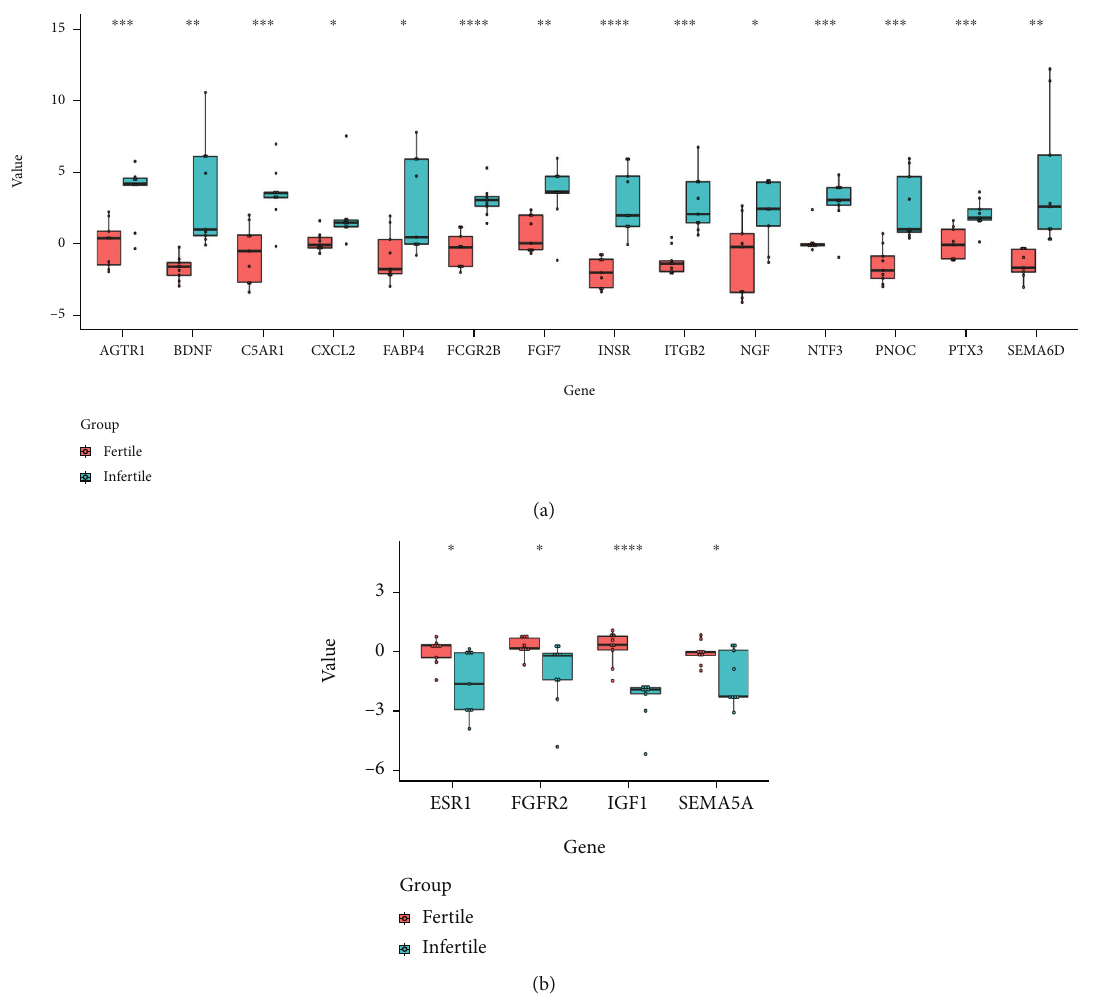
Figure 9: Expression of DEIRGs in the endometria of the infertile and fertile females with endometriosis. (a) Upregulated DEIRGs were highly expressed in the infertile group. (b) Downregulated DEIRGs were decreased in the infertile group (Unpaired Student ’ s t test was used to compare two groups. ∗ P < 0 : 05 ; ∗∗ P < 0 : 01 ; ∗∗∗ P < 0 : 001 ; ∗∗∗∗ P < 0 : 0001